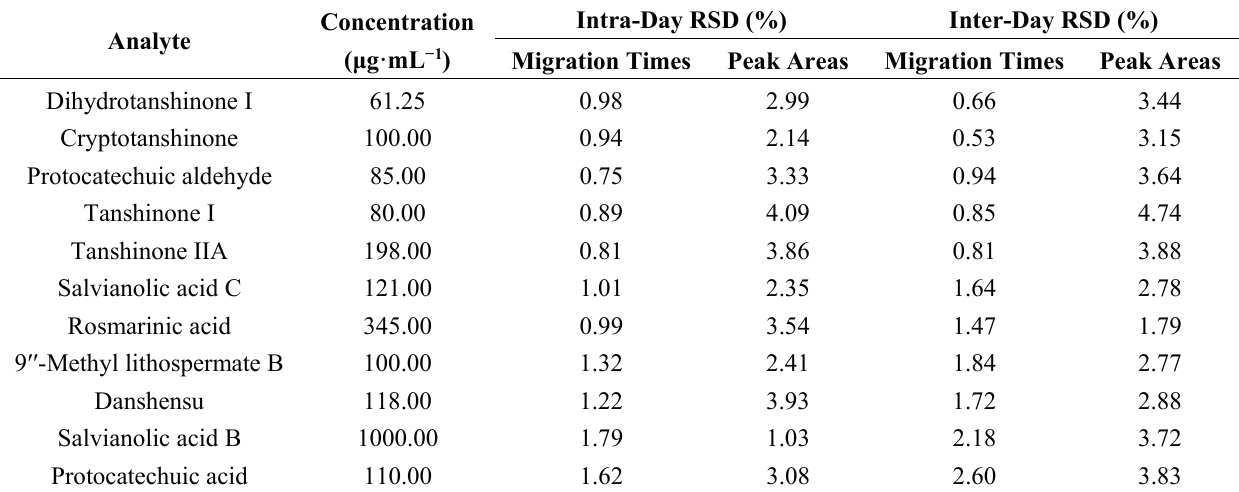
Table 2. Precision test of the optimized MEKC method ( n =